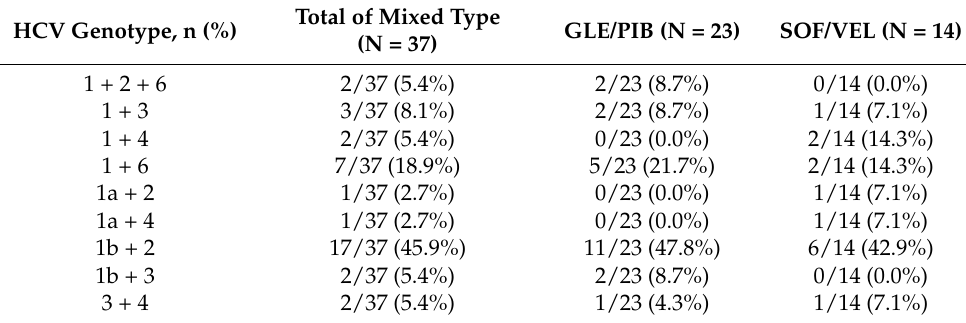
Table 2. Frequency of mixed hepatitis C virus